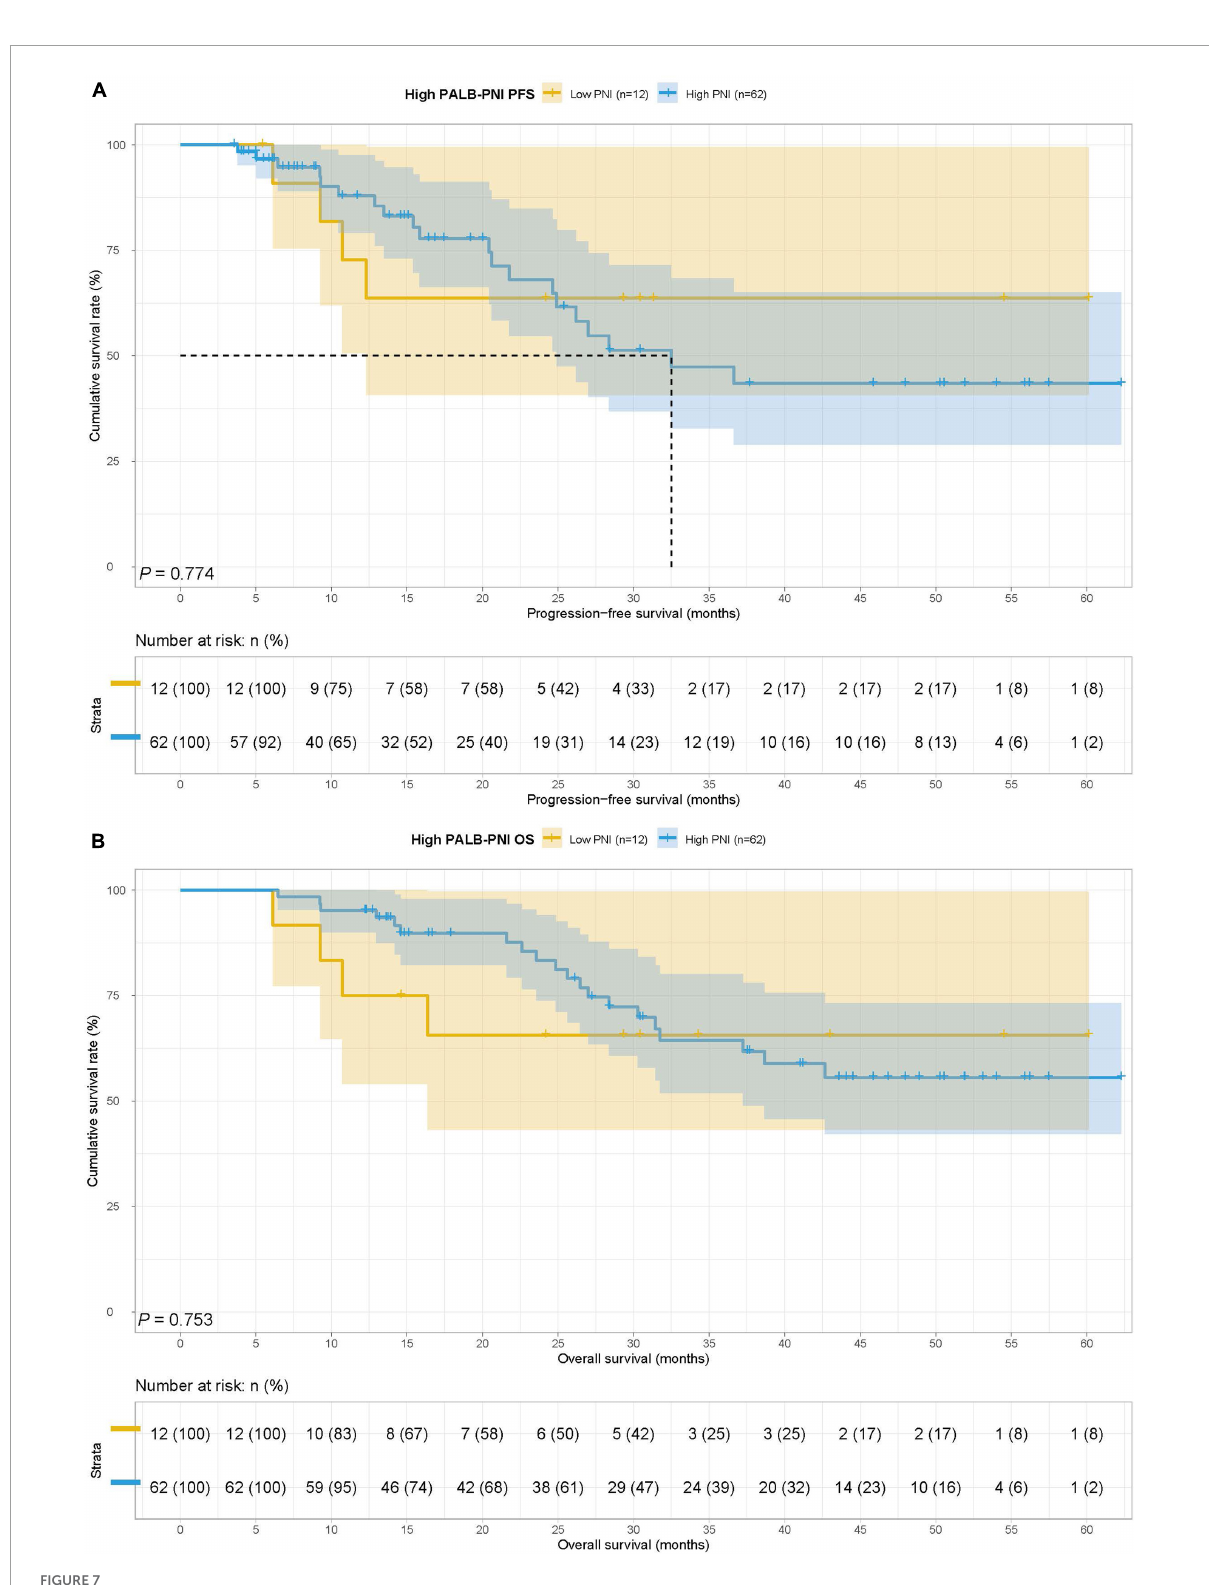
FIGURE7 Prognostic nutrition index related survival curve of (A) PFS and (B) OS in the high PALB group.